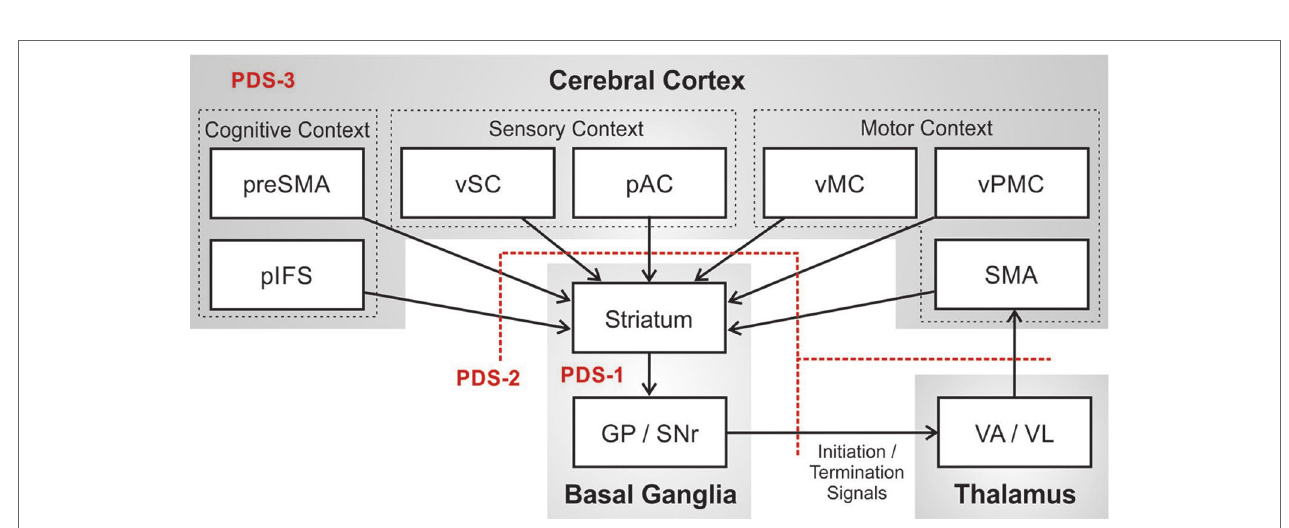
FIGURE 3 | Potential impairments of the basal ganglia motor loop that may contribute to persistent developmental stuttering (PDS), specifically the basal ganglia (PDS-1); axonal projections between cerebral cortex, basal ganglia, and thalamus (PDS-2); and the network of cortical regions involved in speech (PDS-3). (Abbreviations: GP = globus pallidus; pAC = posterior auditory cortex; pIFS = posterior inferior frontal sulcus; pre-SMA = pre-supplementary motor area; SMA = supplementary motor area; SNr = substantia nigra pars reticulata; VA = ventral anterior thalamic nucleus; VL = ventral lateral thalamic nucleus; vMC = ventral motor cortex; vPMC = ventral premotor cortex; vSC = ventral somatosensory